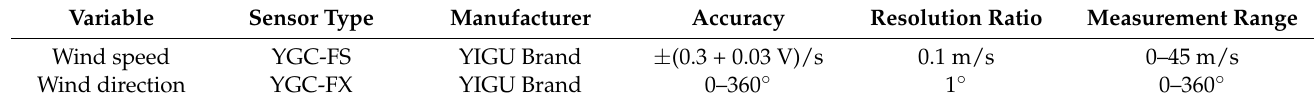
Table 2. Detailed parameters of the instruments used in the field measurements.